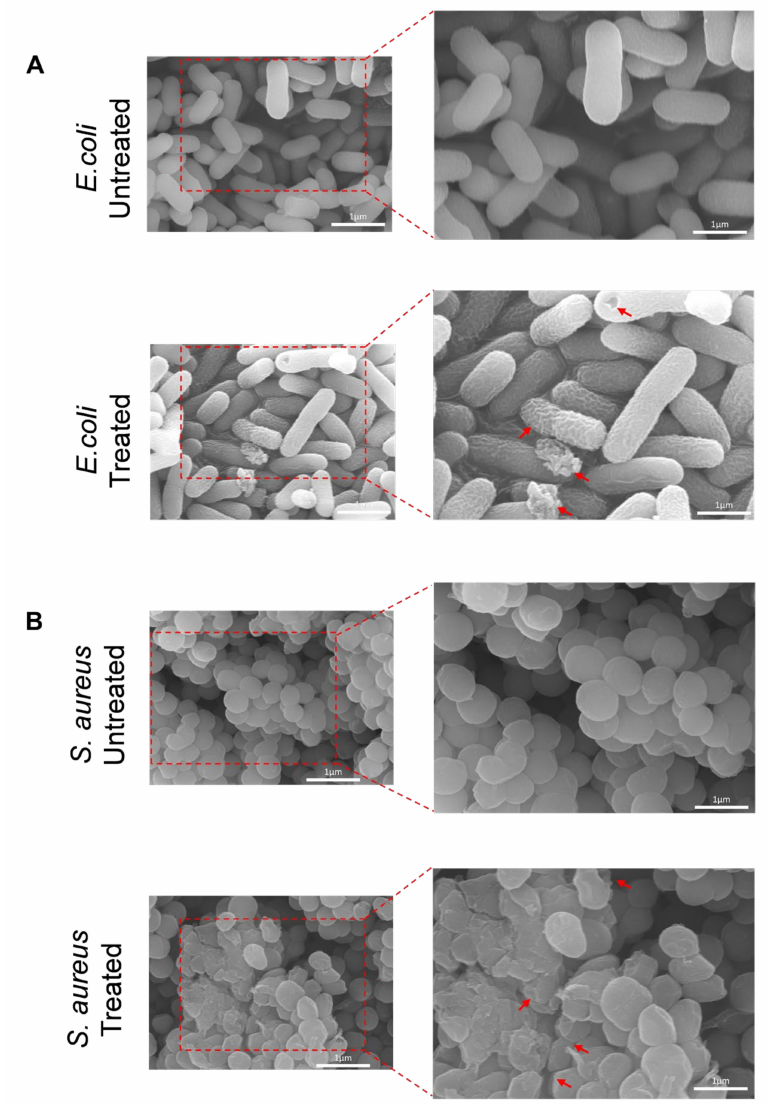
Figure 7. SEM images of PG-NOW untreated and 1000 µ M-treated ( A ) E. coli (K-12) and ( B ) S. aureus , showing deformed structures, pores, and appearing corrugated (indicated with red